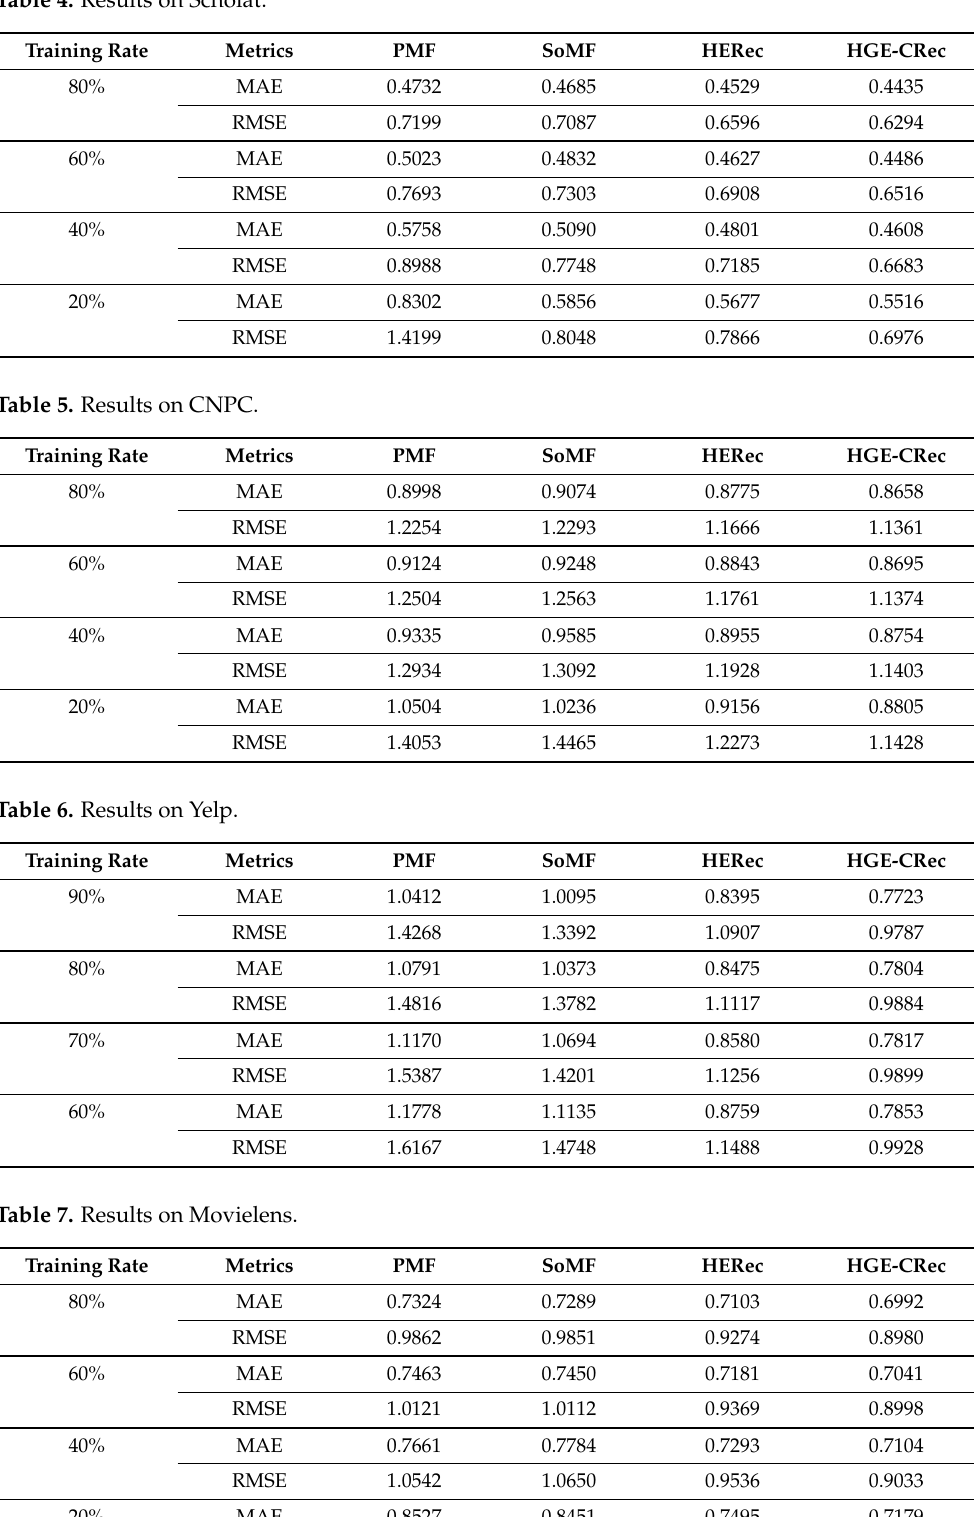
Table 4. Results on Scholat.